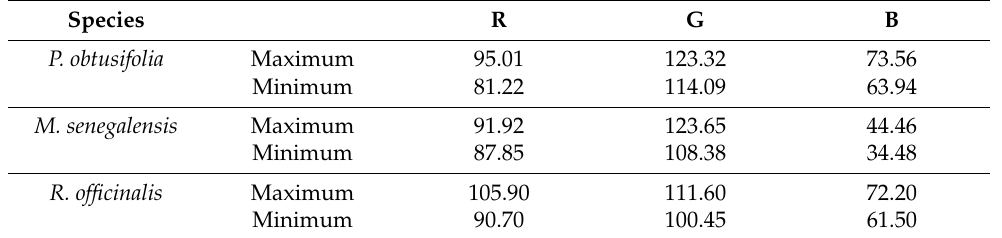
Table 1. Maximum and minimum values of RGB in P. obtusifolia, M. senegalensis, and R. officinalis